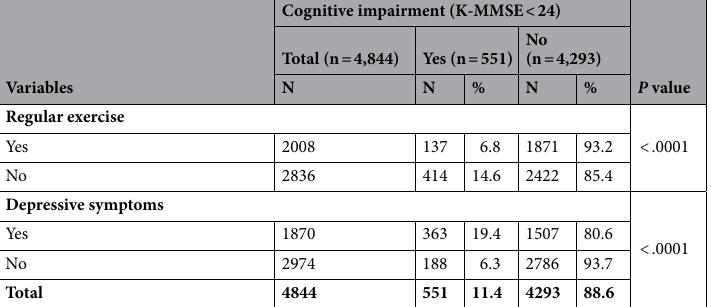
Table 1. General characteristics of the study subjects at the first point of change (2006 → 2008). ADL activities of daily living; IADL instrumental activities of daily living; BMI body mass index; MMSE mini-mental state examination. † Hypertension, diabetes, cancer or malignant tumors, chronic lung disease, liver disease, heart disease, cerebrovascular disease, psychiatric disease, arthritis, and